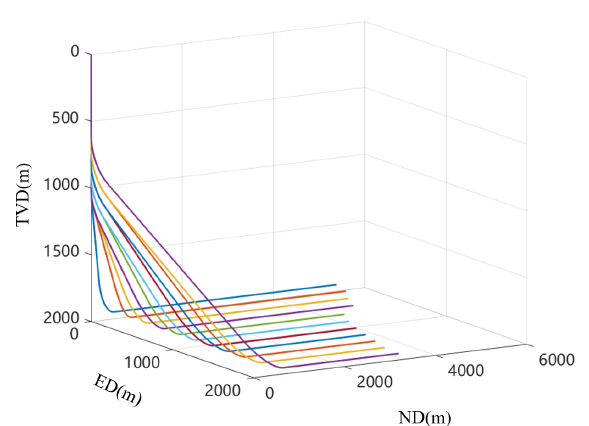
Fig. 5. Schematic of three-dimensional horizontal shale gas